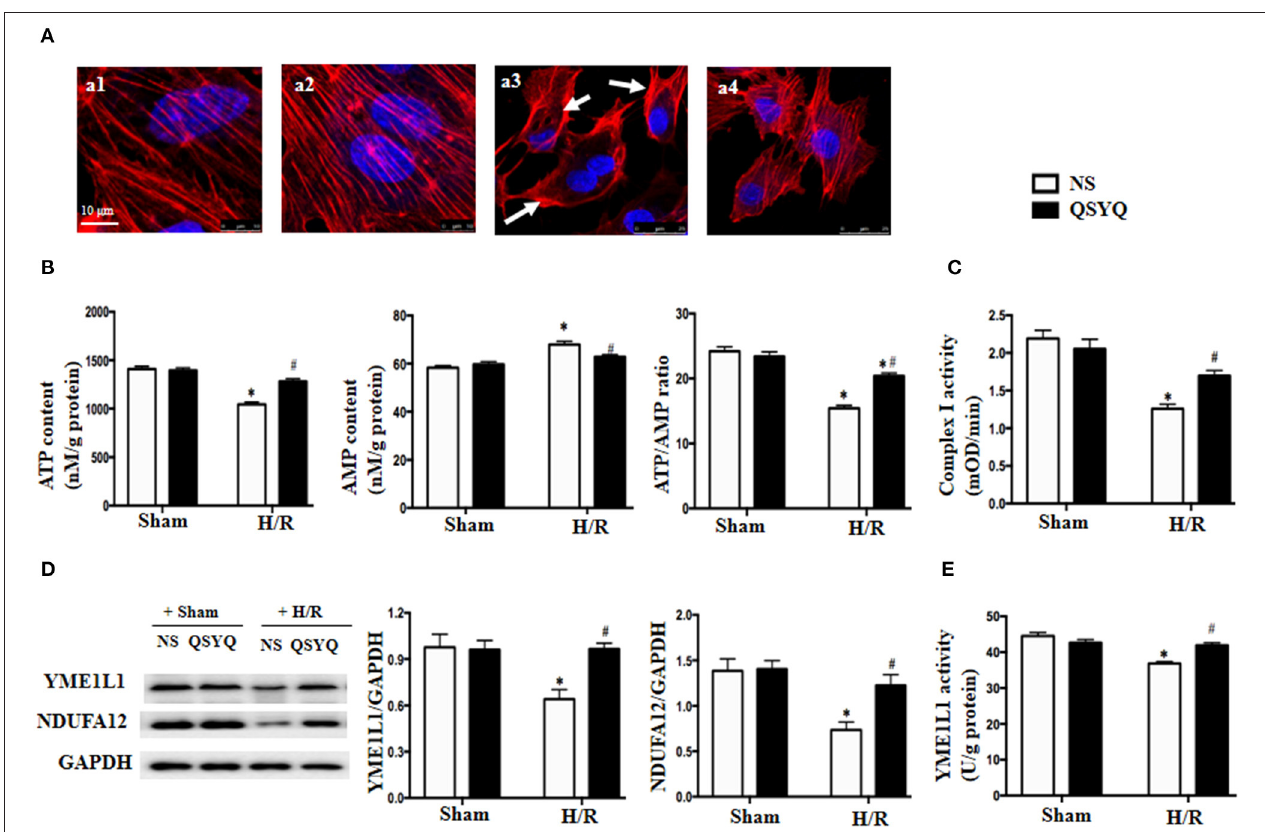
FIGURE 4 | Effect of pretreatment with QSYQ on cytoskeleton, ATP/AMP content, the expression of YME1L1 and NUDFA12 and complex I activity after H/R. (A) The F-actin cytoskeleton in HCMECs (red). Arrow: F-actin cytoskeleton that is concentrated at the periphery of cell and disintegrated. Bar = 10 µ m. a1: NS + Sham group; a2: QSYQ + Sham group; a3: NS + H/R group; a4: QSYQ + H/R group. (B) Quantitative measurement of ATP and AMP by ELISA in HCMECs. (C) Quantitative measurement of complex I activity by ELISA in HCMECs. (D) Representative western blot bands and relative densitometric values of YME1L1 and NUDFA12